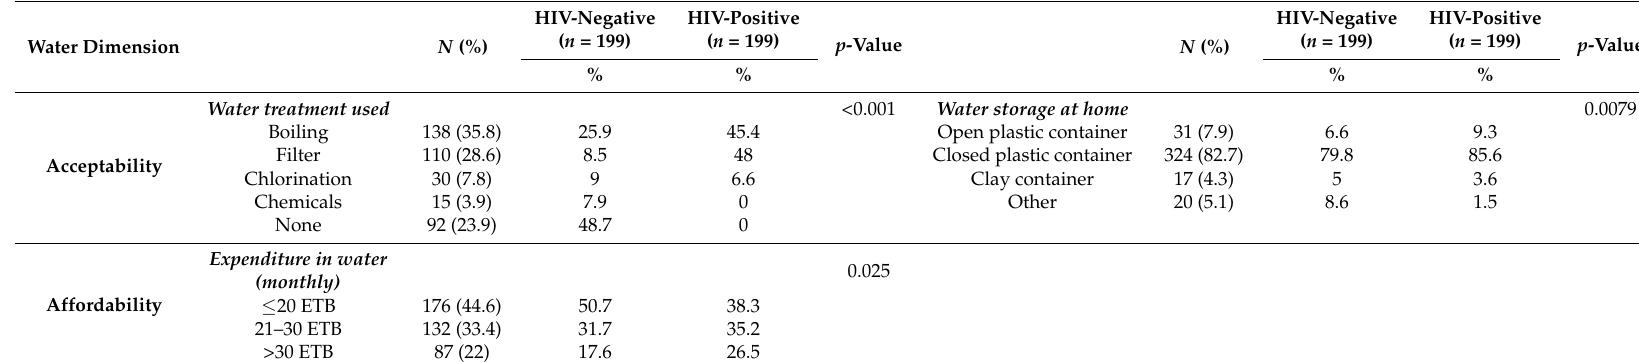
Table 4. A comparison of water acceptability and affordability among the HIV-negative and HIV-positive groups in Wukro ( N = 398).